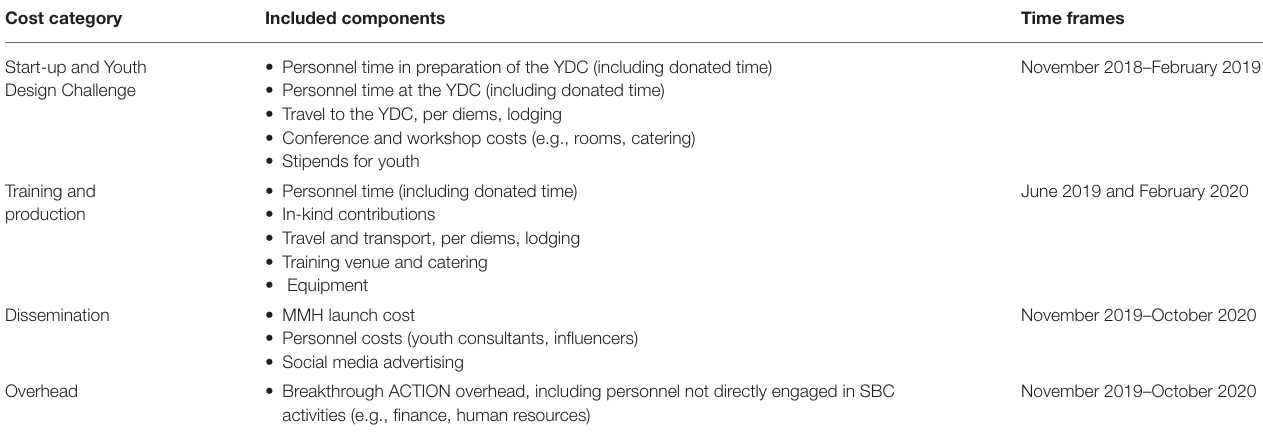
TABLE 1 | Cost components included in MMH video costing